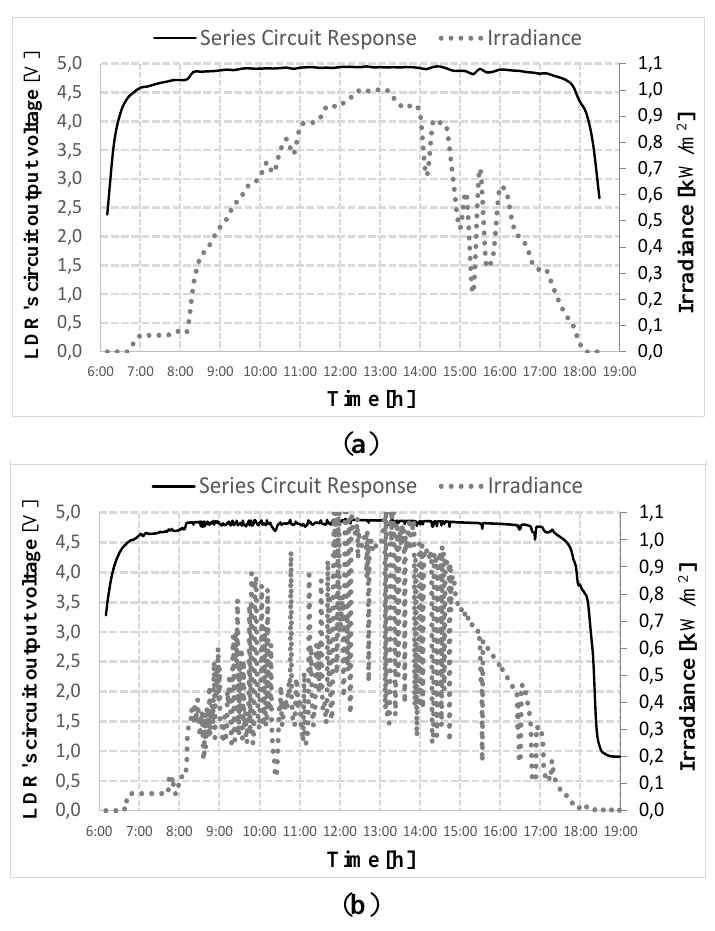
Figure 2. LDR series circuit response and irradiance during the day time, ( a ) sunny day and ( b ) cloudy